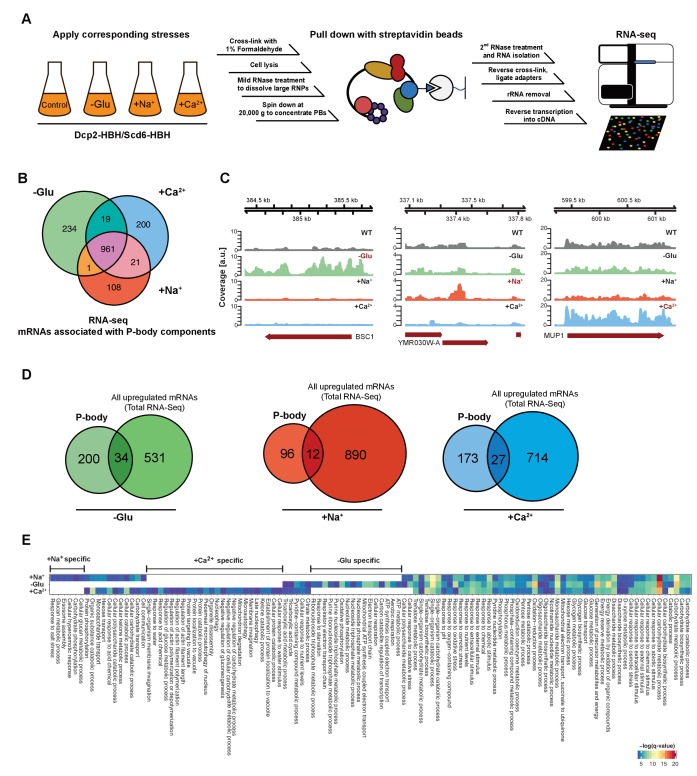
RNA-Seq reveals stress-specific mRNA subsets associated with P-body components at membranes.(A) RNA-Seq library preparation workflow. Cells expressing Dcp2-HBH or Scd6-HBH were stressed for 10 min, followed by cross-linking with formaldehyde. After cell lysis, centrifugation was performed to enrich membrane fractions. Cross-linked complexes were subsequently purified via streptavidin affinity purification. mRNAs were isolated and ligated with adapters. cDNA libraries were prepared by reverse transcription and sequenced using single-read RNA-Seq. (B) Venn diagram illustrating the intersections among mRNAs associated with P-body components (p<0.05) under glucose depletion and osmotic stress conditions with Na+ or Ca2+, relative to the no stress condition as determined by RNA-Seq. (C) Read coverage plots (average over five biological replicates) of RNA-Seq data mapped to P-body associated genes under specific stress conditions. (D) Venn diagrams showing the intersections between mRNAs specifically associated with P-body components under glucose depletion, Na+ or Ca2+ stresses and all mRNAs that are upregulated upon the same treatment according to total RNA-Seq. (E) Enrichment analysis of P-body-associated genes under different stress conditions against Gene Ontology's (GO) biological processes (BP). Significantly enriched pathways (q-value <0.05) from hypergeometric tests are presented in a clustered heatmap. Rows and columns correspond to stress conditions and pathways, respectively, and the negative logarithms of q-values are color-coded from blue (low) to red (high).